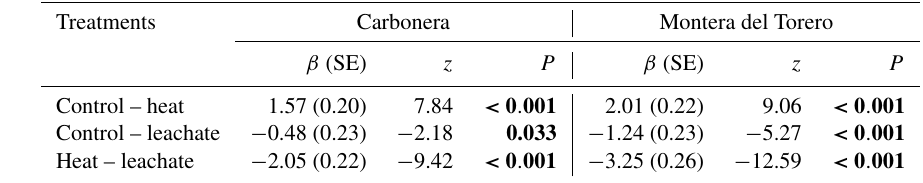
Table 1. Statistical results of Wald- z tests evaluating pairwise differences in the probability of germination between treatment levels ( β : estimate parameter; SE: standard error). Significant P values are highlighted in bold.